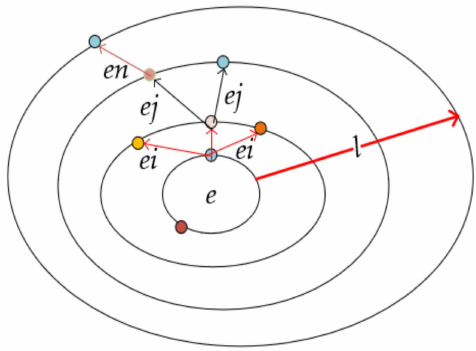
Figure 1. This is a figure for the energy of changed knowledge absorbed by knowledge in